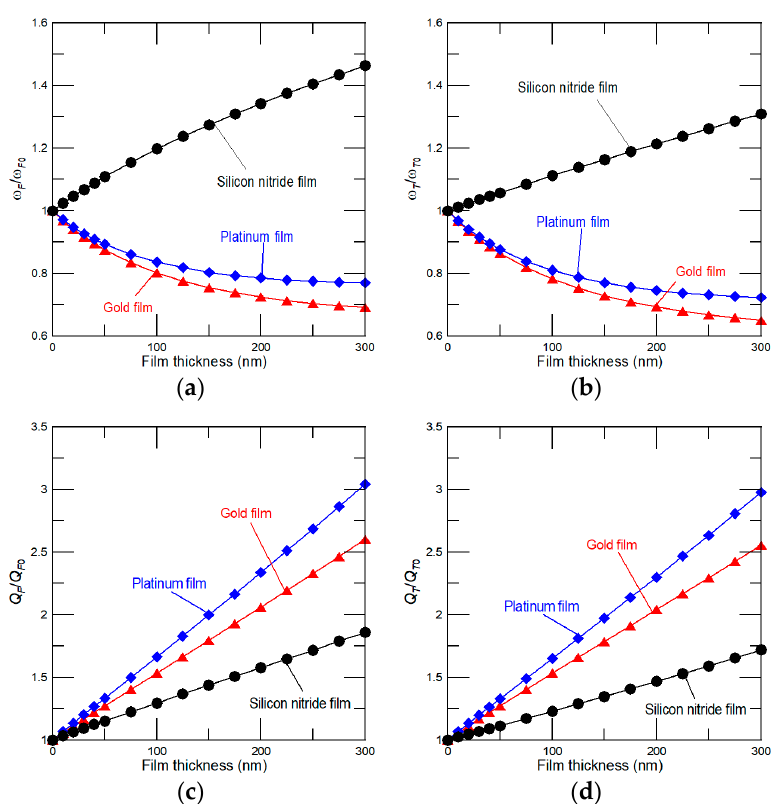
Figure 3. Dependencies of ( a , b ) the fundamental resonant frequencies and, correspondingly, ( c , d ) Q - Figure factors of the silicon cantilever on film thickness for flexural and torsional vibrational modes.